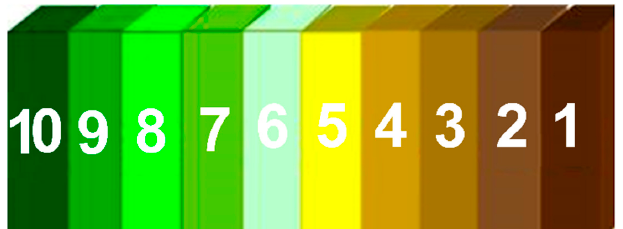
Figure 13. Color-Likert scale for evaluation of green chemistry principles. The numbers meaning: 1= totally brown, 2= very brown, 3= moderately brown, 4= slightly brown, 5= brown to green transition, 6= slight green approach, 7= good green approach, 8= very good approach, 9= great green approach, 10= totally green. Adapted from Ref. [21].